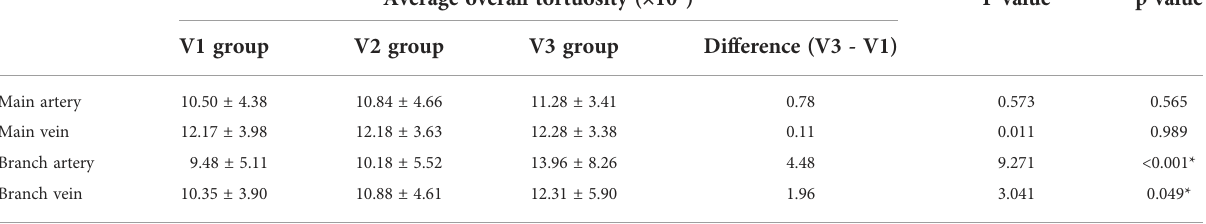
TABLE 3 Comparison of the average overall tortuosity values among groups with different levels of DR severity.